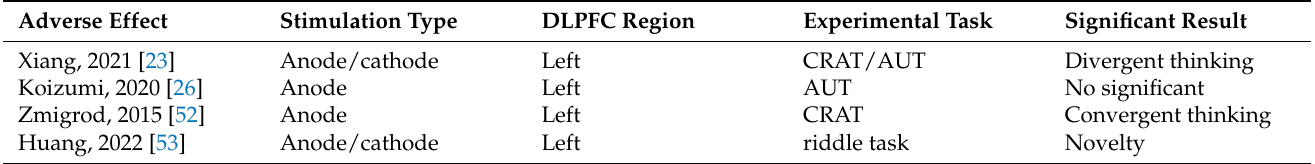
Table 4. The differences between current research and other similar